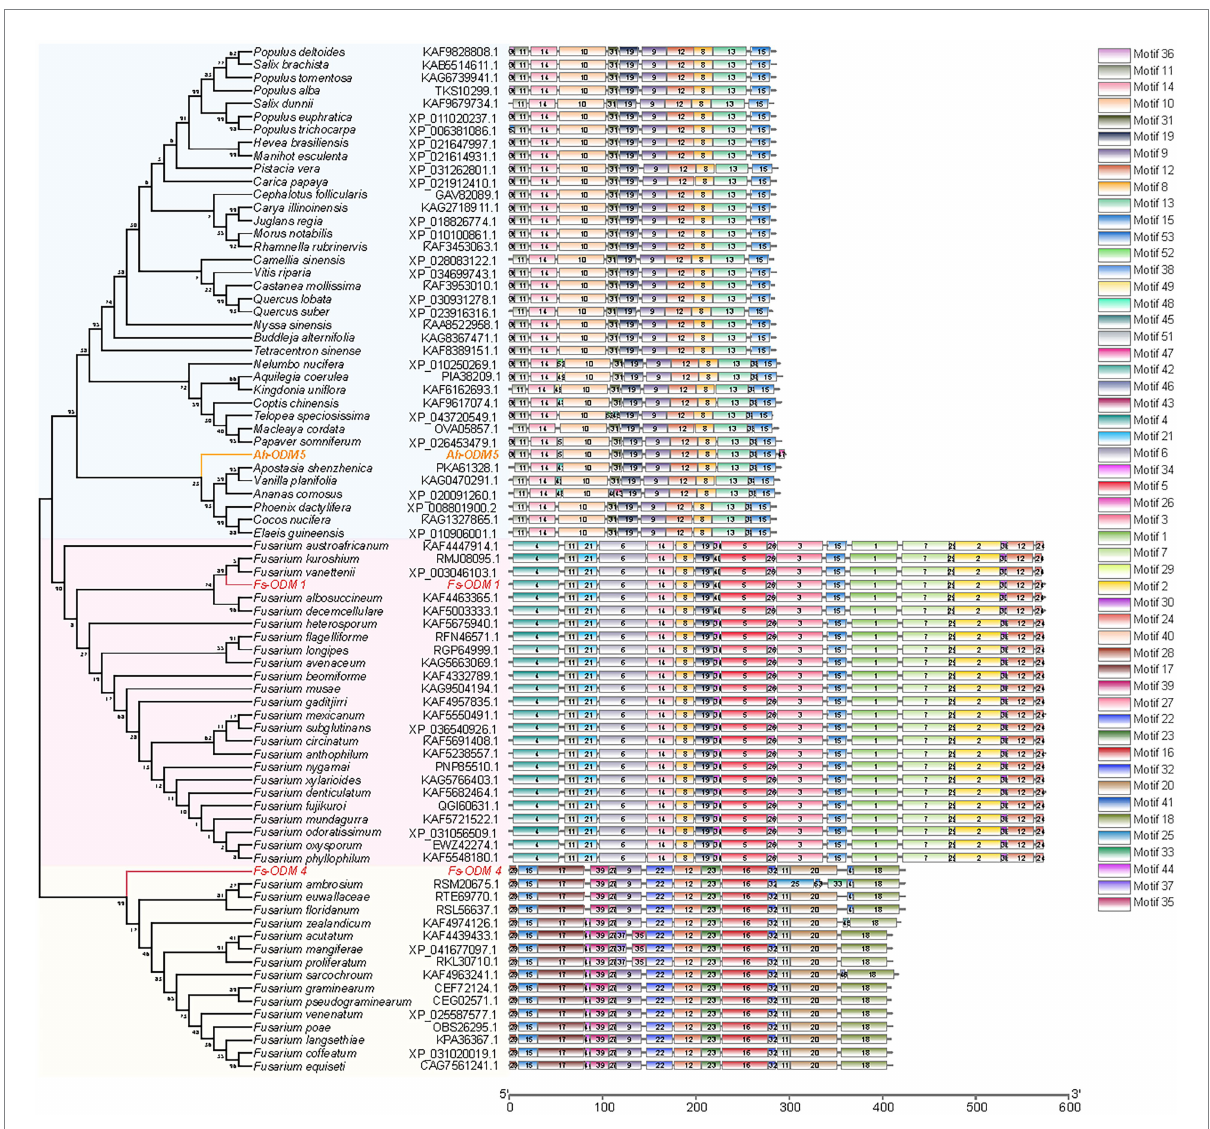
FIGURE 6 Comparison of sequence motifs of ODMs and developmental tree analysis of ODMs . The amino acid sequences of ODMs of 37 species of plants are shown in light blue block, and the amino acid sequences of ODMs of 39 species of Fusarium strains are shown in pink ( Fs -ODM-1) and light yellow ( Fs -ODM-4) blocks. Raw data are provided in EXCEL